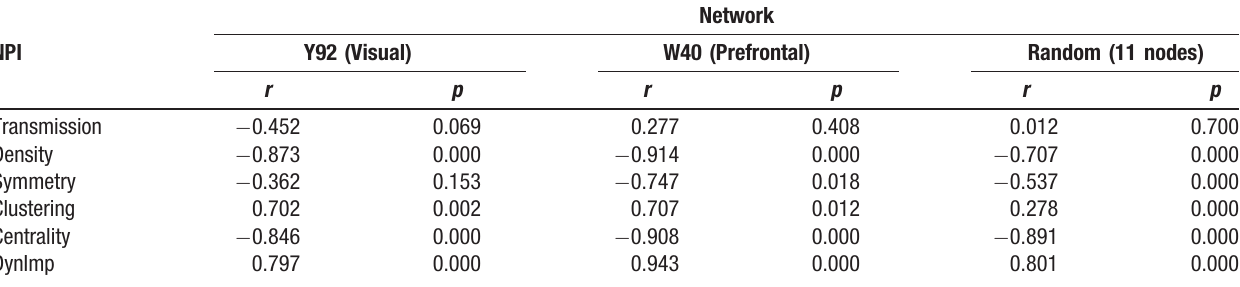
Table 1. Pearson correlation coefficients (r) and associated p-values (p) for correlations with Shapley values for: the three NPI values, the clustering coefficient, betweenness centrality, and dynamical